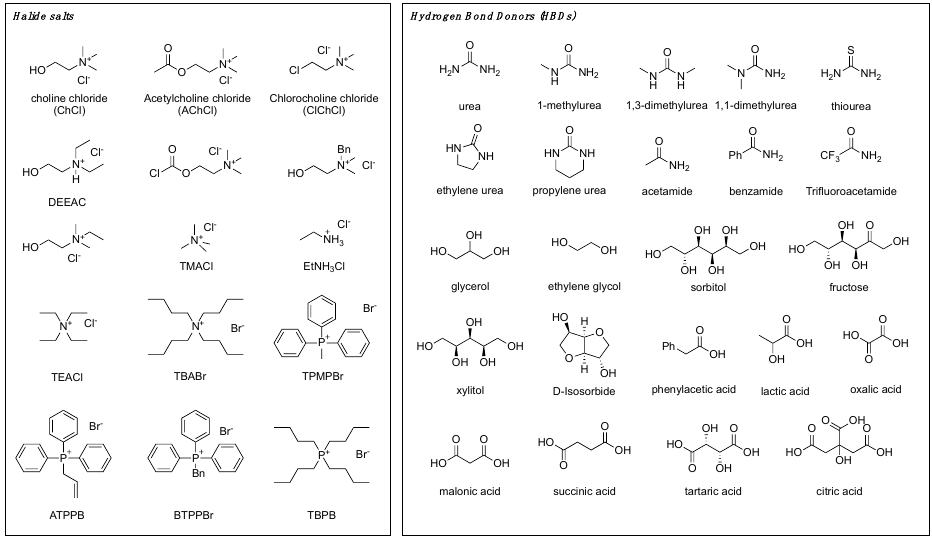
Figure 1. Selected examples of HBAs and HBDs for the formulation of DESs. Bn = benzyl, Ph = phenyl.